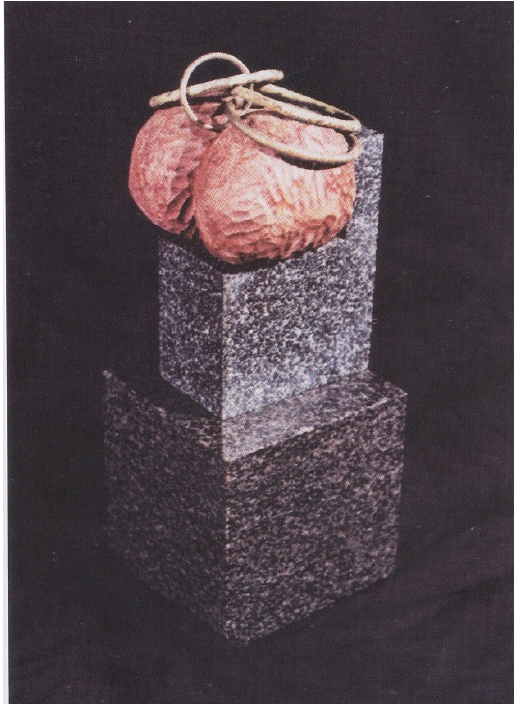
Figure 6. Leon Podsiadły, Alpha Yaya Diallo , 2006 or 1990s, brass, wood, stone. Photograph by Stanisław Sielicki. After: (Wąs 2012a, p. 41). Photo used with the permission of the artist’s family.